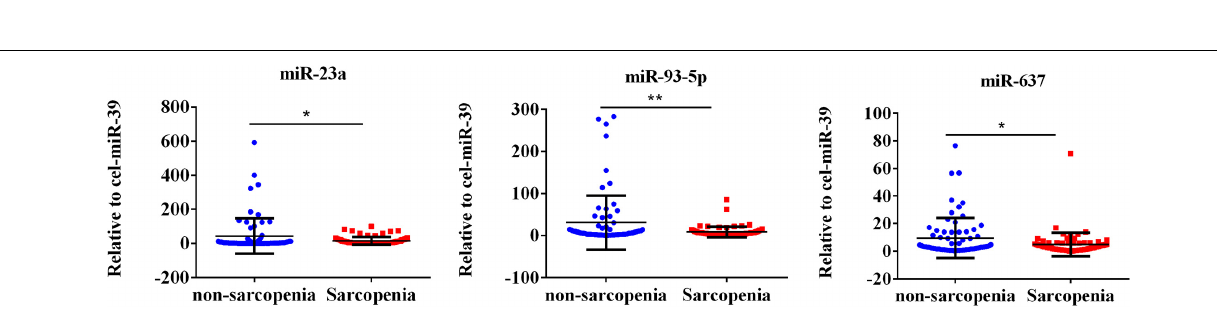
FIGURE 1 | Changes in circulating microRNAs in response to sarcopenia in the elderly. The expression level of microRNAs (miRNAs) were normalized using spike-in cel-miR-39. Unpaired t -test was used for these data. *Compared to non-sarcopenia of the elderly; * P < 0.05; n = 20.